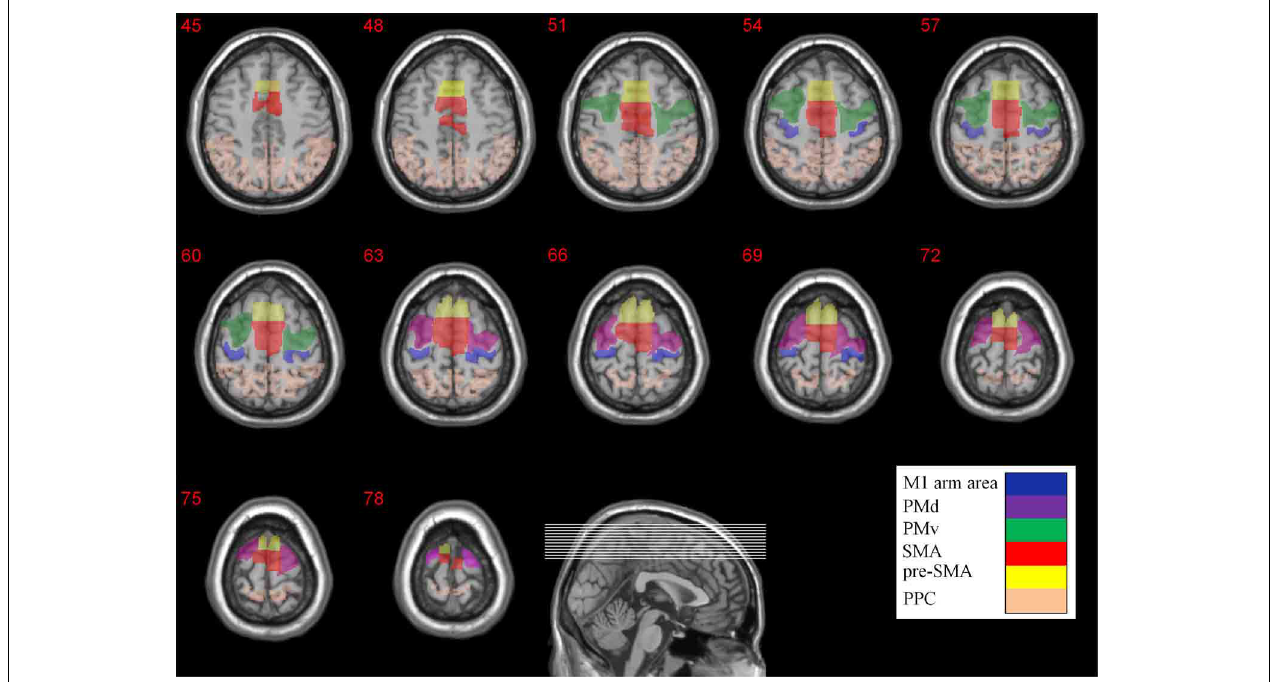
FIGURE 2 | Anatomical locations of the different ROIs. The M1 arm area, PMd, PMv, SMA, pre-SMA, and PPC are color coded. The Z coordinates are depicted above each transverse